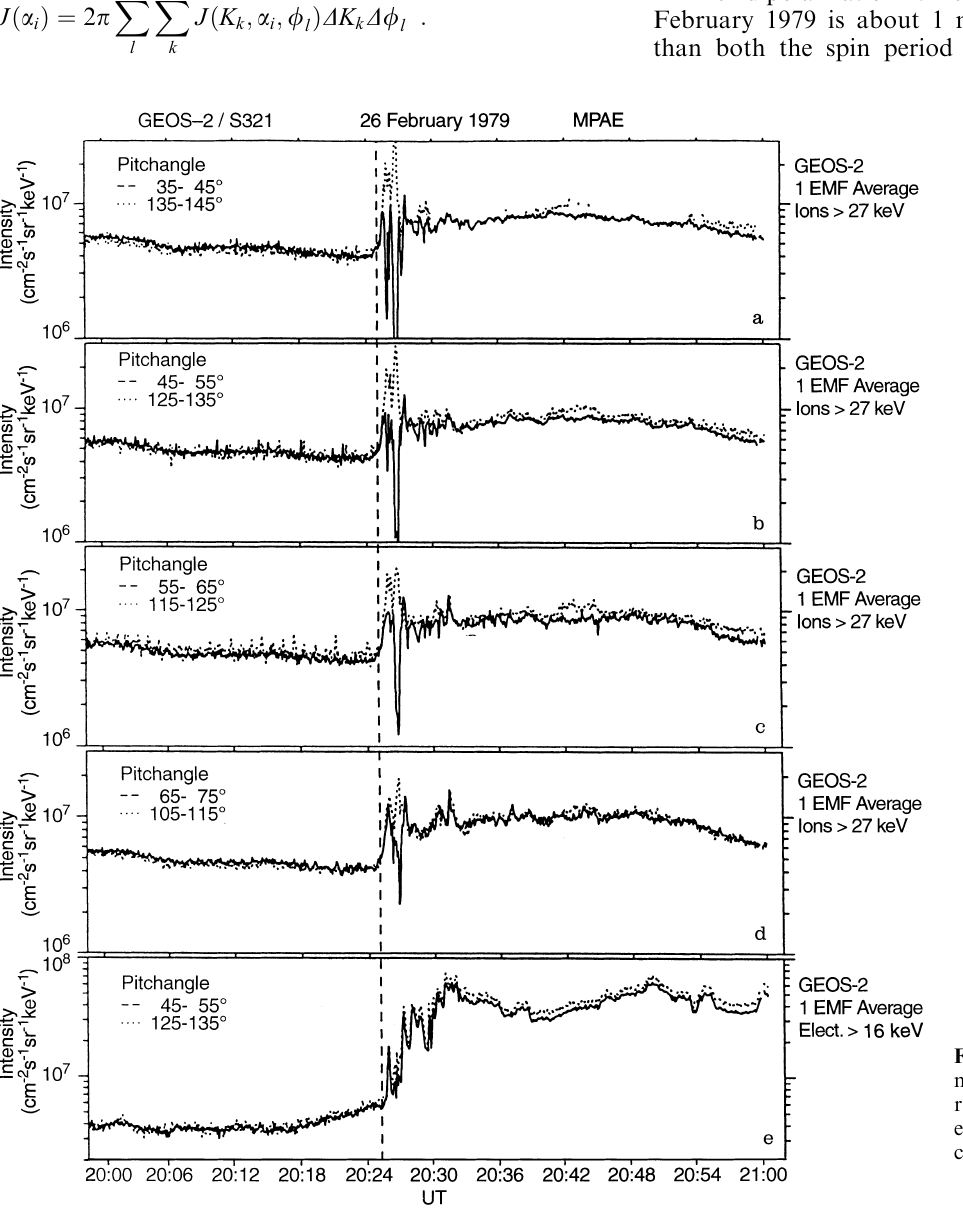
Fig. 6a – e. Ion pitch angle asym- metries for four pitch angle ranges in a – d , and in e for one electron pitch angle range